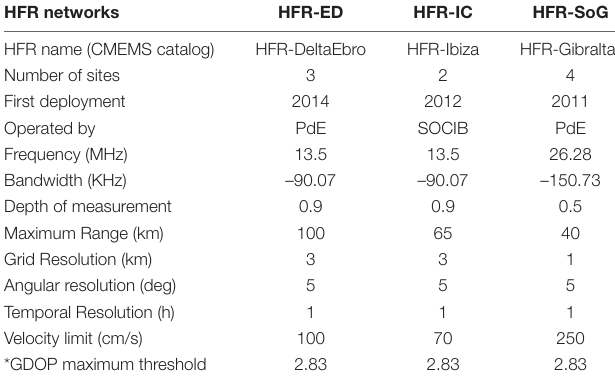
TABLE 1 | Technical specifications of the SeaSonde HFR systems used in this